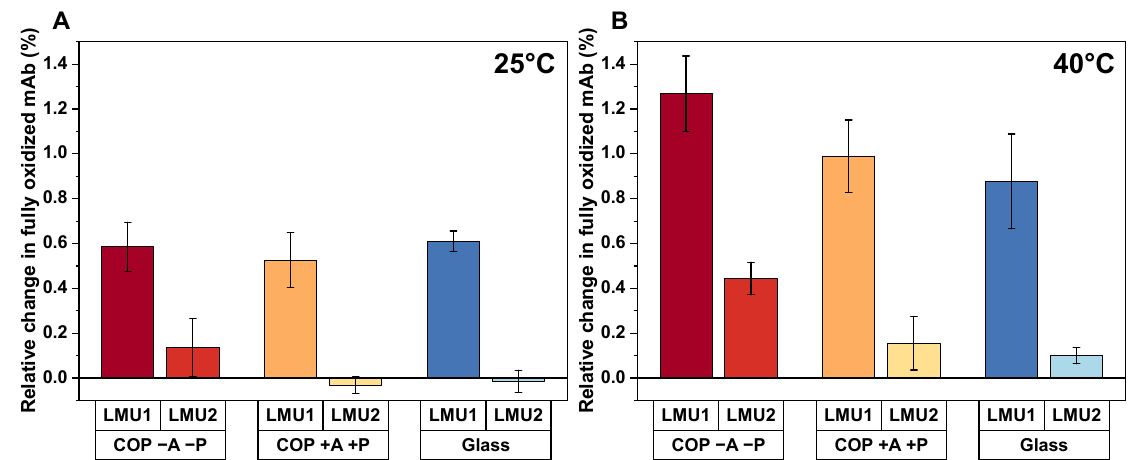
Figure 5. Relative change in fully oxidized mAb determined by hydrophobic interaction chromatography (HIC) for LMU1 and analytical protein A chromatography (PA) for LMU2 after 3 months of storage at 25 °C ( A ) and 40 °C ( B ). The bars are means ( n = 3) ± standard deviation. COP, cyclic olefin polymer; A, absorber; P, pouch.